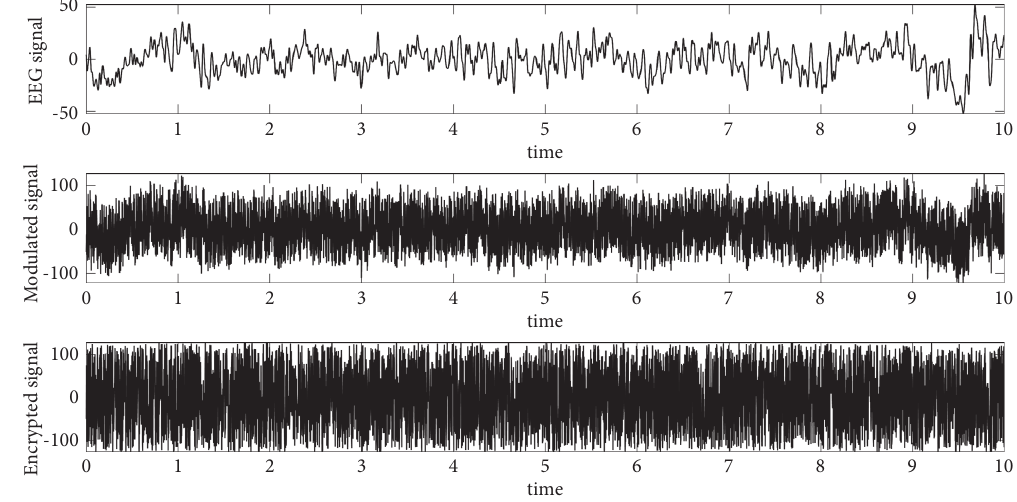
Figure 15: Original EEG signal, modulated signal, and encrypted signal. Table 2: Performance measures of the encryption